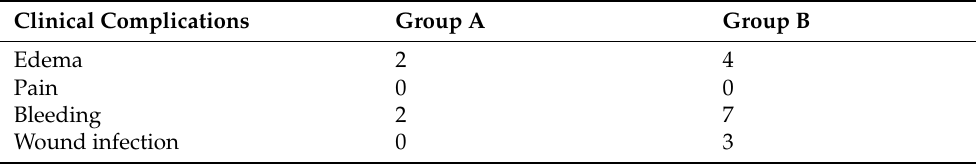
Table 4. Clinical complications classified by